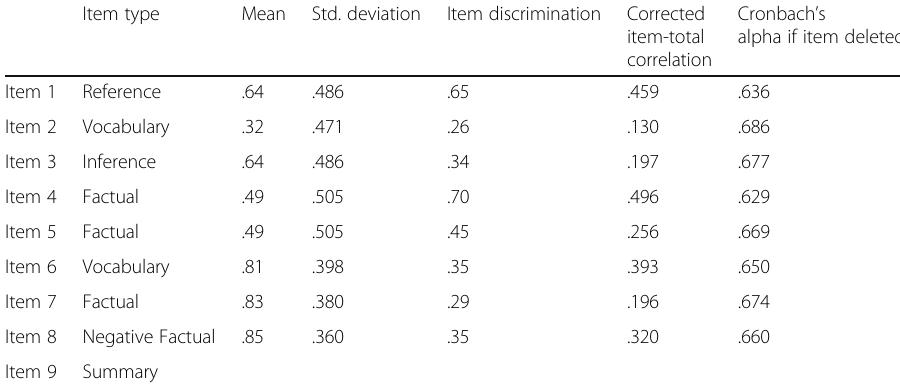
Table 3 Item analysis of the 8 MC reading items from form A ( n =